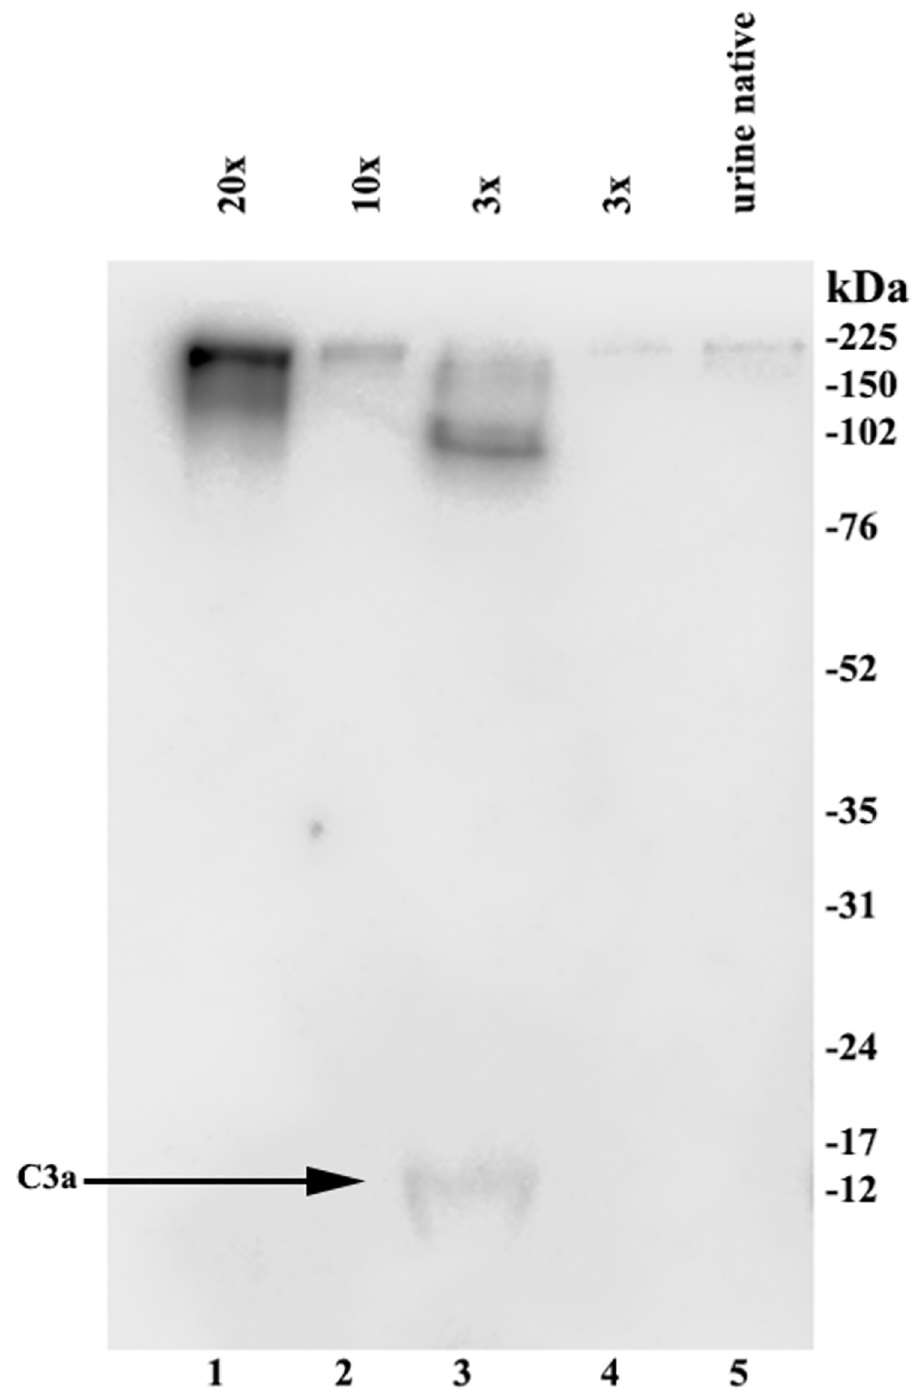
Fig 5. C3a/C3 immunoblot developed with 3F7E2 mAb. Twenty times ( 20x ) concentrated urine from a patient with high C3a/C3 level in urine ELISA (lane 1); ten times ( 10x ) concentrated urine from a patient with medium range C3a/ C3 level in urine ELISA (lane 2); three times ( 3x ) concentrated urine from patient with C3a fragment (shown by arrow ) in urine (lane 3); three times ( 3x ) concentrated urine from patient with undetectable C3a/C3 level in urine ELISA (lane 4); non-concentrated ( native urine) urine (lane